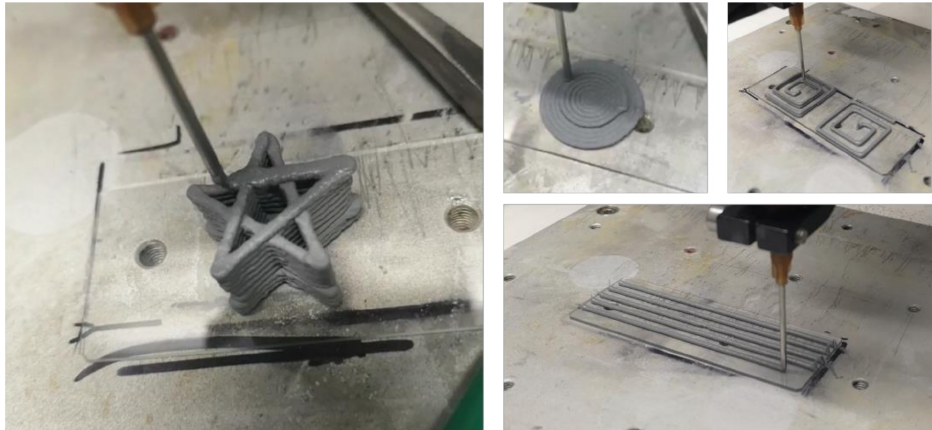
Figure 7. Several complex structures through 3D